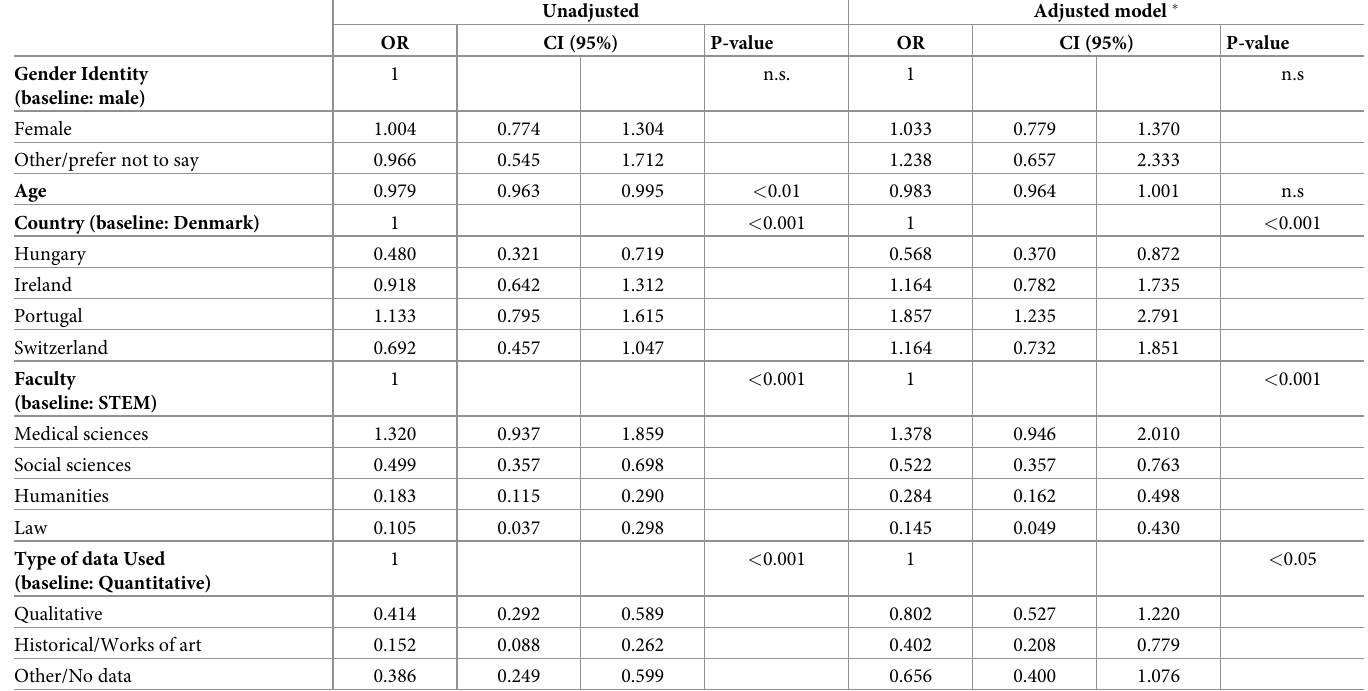
In the unadjusted logistic regression analysis (Table 6) all demographic and study-specific factors except gender identification predicted granting guest authorship at a statistically signif- icant level. In the adjusted analysis participant’s age was no longer statistically significant, whereas country ( p < 0.001), faculty ( p < 0.001) and type of data used ( p < 0.05) were. Table 6. Results from unadjusted and adjusted logistic regression focusing on factors explaining whether PhD students had allowed someone in power to become co-authors of papers even though they had not made a significant contribution to them (once or several times during the past year) ( n = 1,096)—Odds ratio (OR). Unadjusted Adjusted model � OR P-value